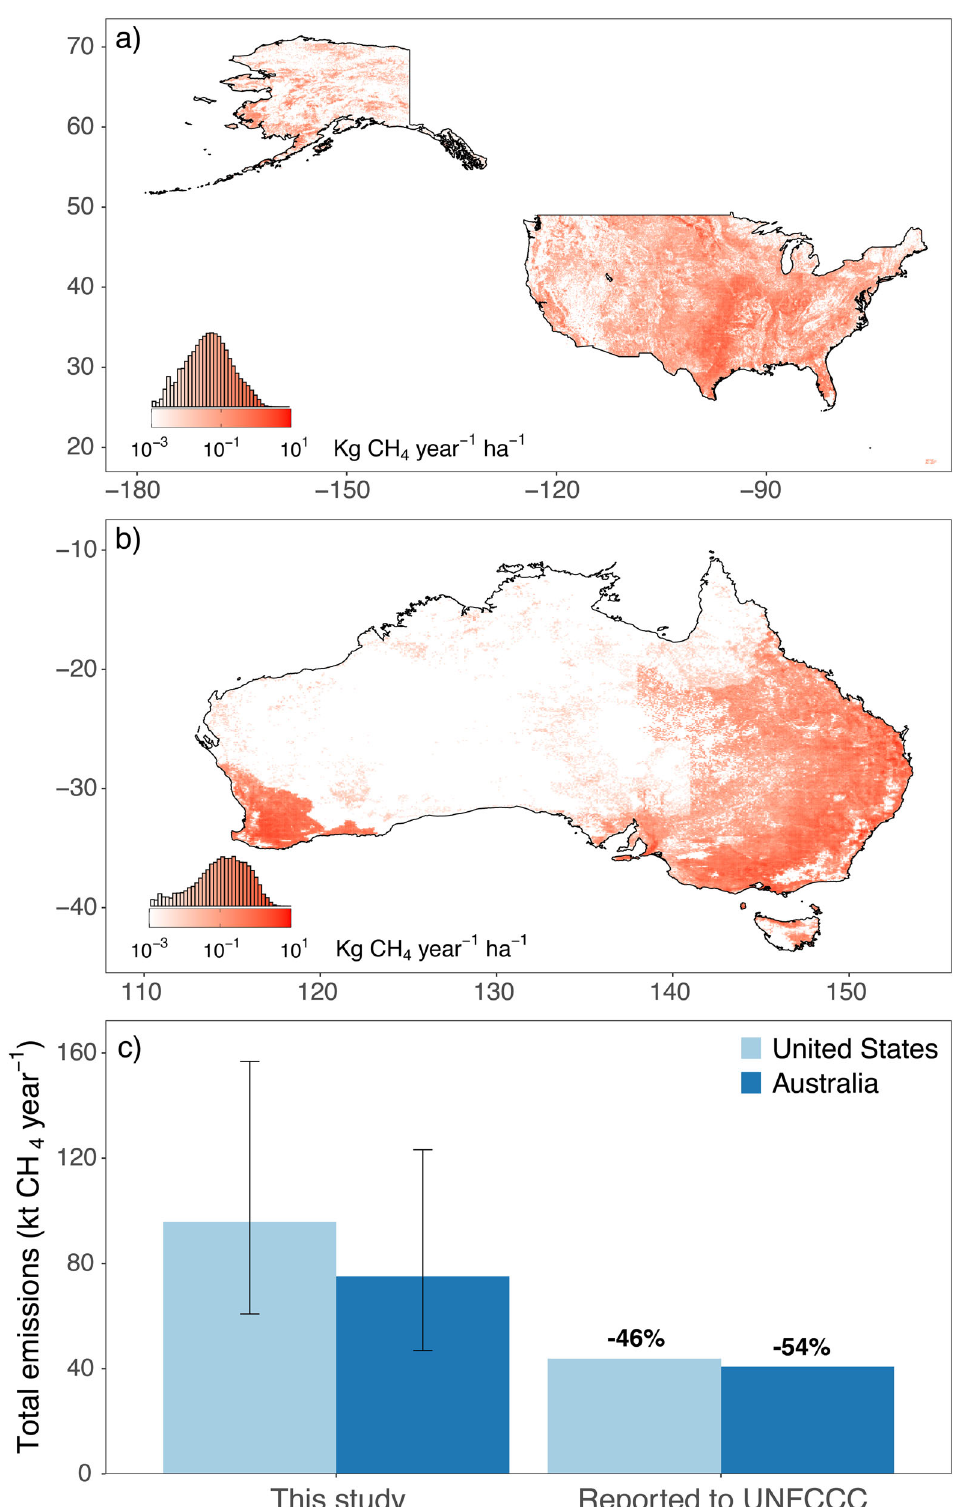
Fig. 3 Methane emissions from agricultural ponds in the United States and Australia. a Spatial model at fi ve arcmin resolution for annual methane emissions for agricultural ponds in the United States (total of 96 kt CH 4 year − 1 ). b Spatial model at fi ve arcmin resolution for annual methane emissions for agricultural ponds in Australia (total of 75 kt CH 4 year − 1 ). c Emissions from agricultural ponds calculated in this study (with error bars representing the 95% con fi dence intervals) compared against those from “ Other Constructed Waterbodies ” under “ Land Use, Land Use Change, and Forestry ” reported to UNFCCC 15 in 2020 for the United States and Australia. Percentages indicated above bars quantify the relative decrease from estimates in this study to those in UNFCCC reports. See Fig. S4 for the hotspots of methane emissions in the United States and Australia.